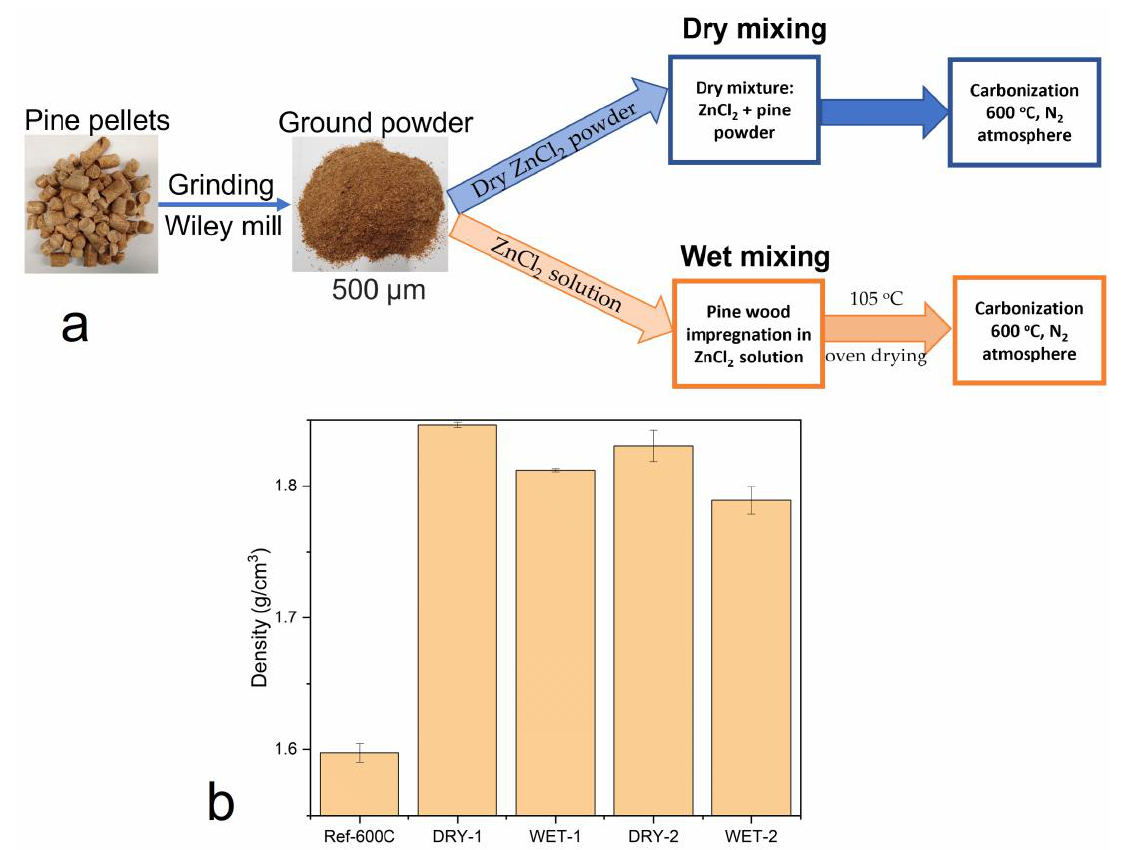
Figure 1. ( a ) Schematic diagram showing the two methods synthesis of activated carbon and ( b ) comparison of the density of the activated carbon from wet and dry activation methods.